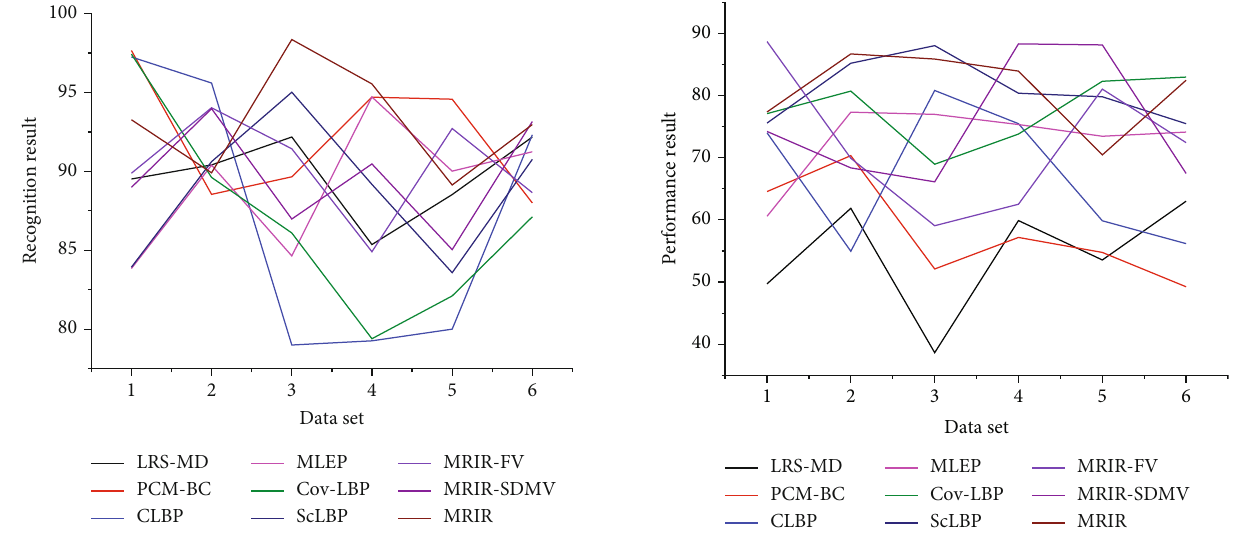
Figure 3: Comparison results of recognition experiments. Figure